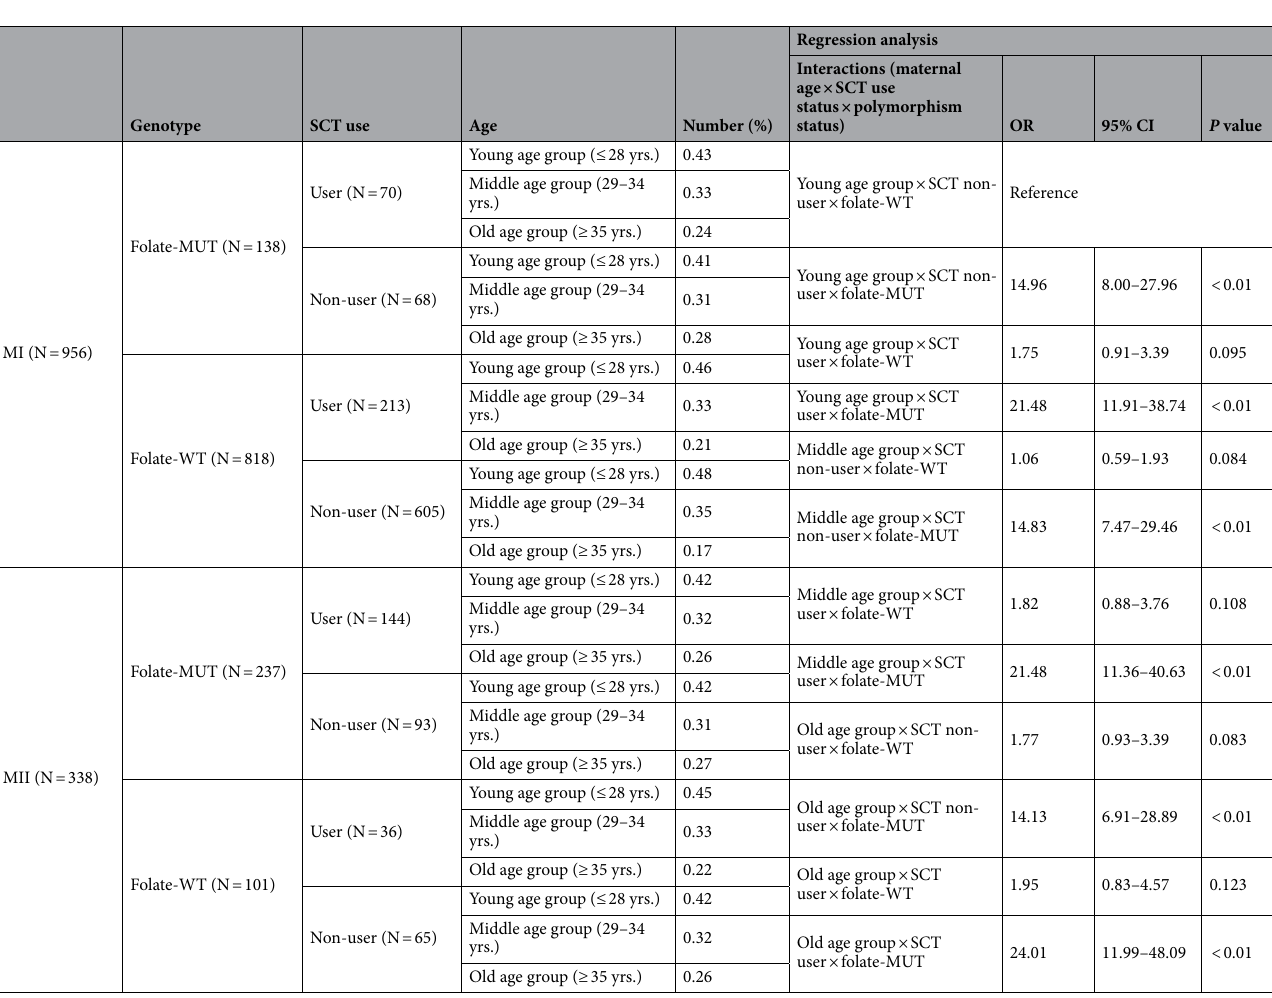
some arm in the young age group to the centromere proximal position in the old age group in ‘wild type SCT non-user women’ and this observation is consistent with the findings from the previous studies 4, 5 . We observed more frequent single recombination events in the pericentromeric regions in the SCT user group as well as among the folate polymorphic genotype bearing women. This is a new finding. We scored ~ 18% of all observed single recombination events in the centromere proximal intervals 1 and 2 among the ‘young age group SCT non- user folate-WT’ women in contrast to ~ 81% of all single recombination events in ‘young age group-folate-MUT SCT user group’ (Table 6). Interestingly, the distribution pattern of single observed recombination events across the age groups remained similar among the women who were SCT user as well as had folate-MUTs. In other words, we did not observe any displacement of single recombinant events towards centromere with age among SCT user folate polymorphic genotype women. This observation is also novel. We compared the spatial distribu- tion of single observed recombinant events among the age groups in pairwise manner through chi square test and found significant difference in the young age group between ‘folate-WT-SCT non-user’ vs ‘folate-MUT-SCT